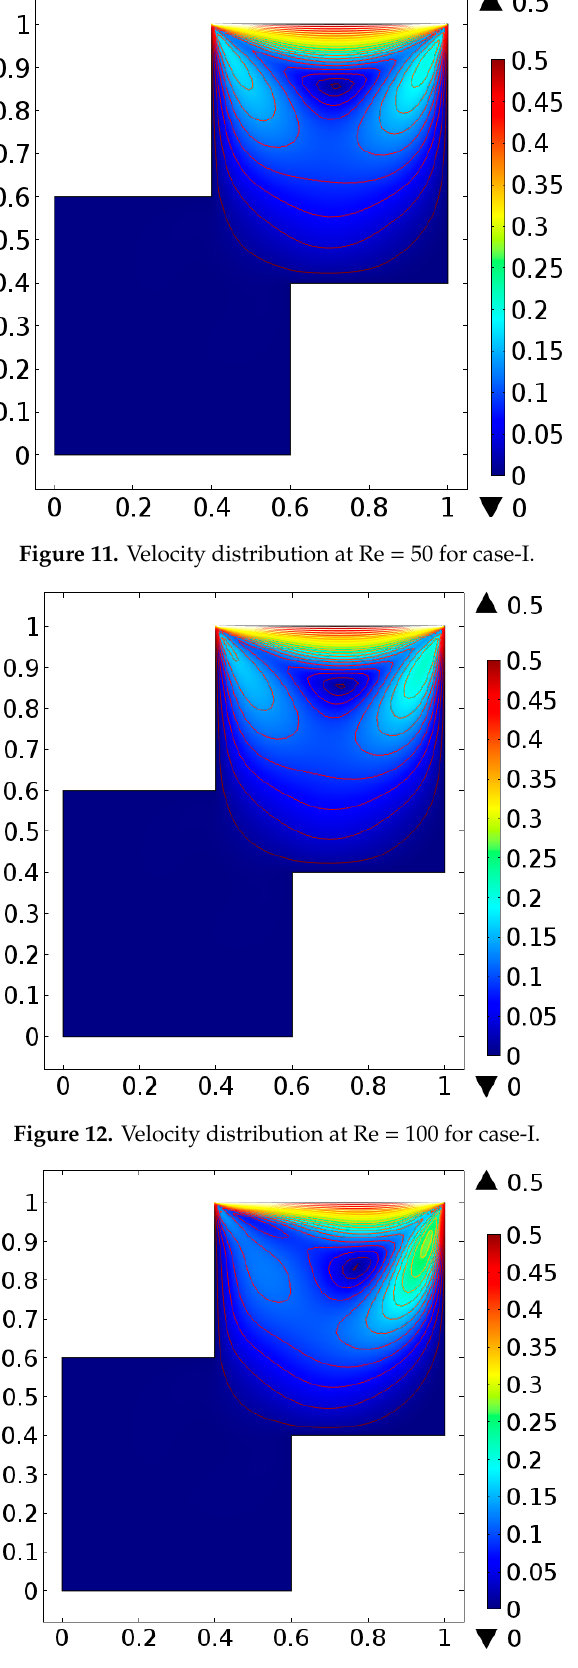
= 400 for Figure 13. Velocity distribution at Re = 400 for case-I. Figure 13. Velocity distribution at Re Figure 13. Velocity distribution at Re = 400 for case-I. Figure 13. Velocity distribution at Re = 400 for case-I.